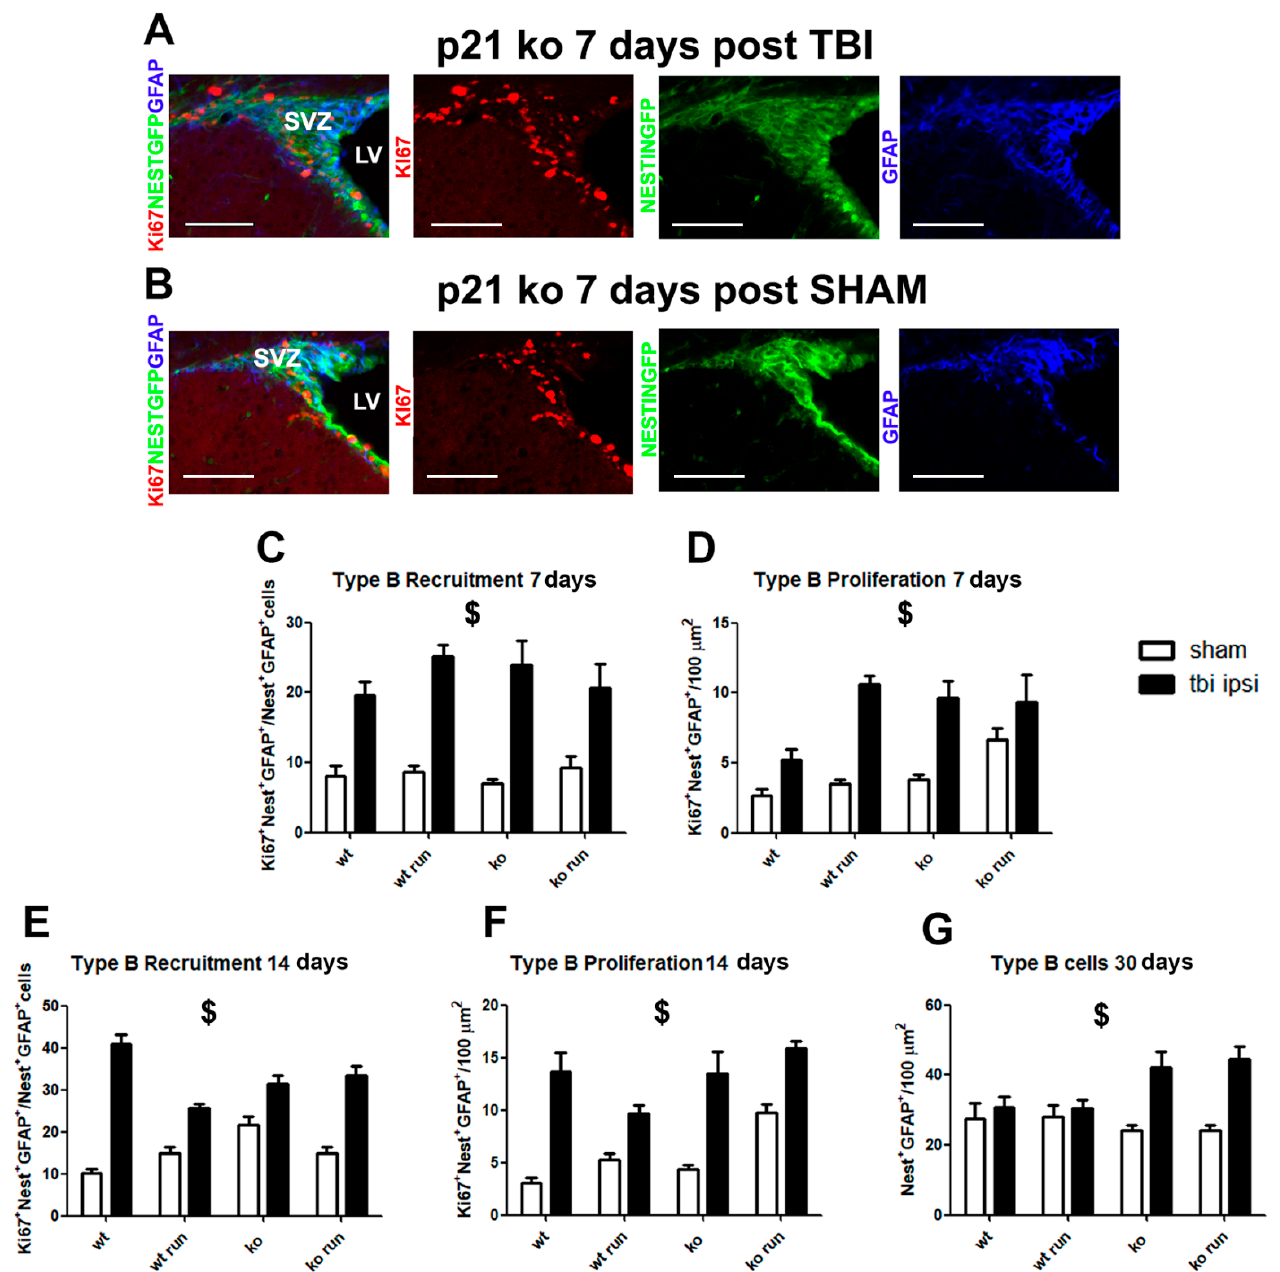
Figure 2. Modulation of type B cells after TBI. ( A , B ) Representative images in coronal sections of the neurogenic processes that occur in the ipsilateral SVZ of p21 ko mice 7 days after TBI (KO TBI, ( A )) and after SHAM (KO SHAM, ( B )). The images show an increment in the pool of proliferating type B cells (Ki67 + /GFAP + /NestinGFP + cells) in the KO TBI animals, with respect to the KO SHAM mice at 7 days after the surgery (N = 5 mice/group). ( C ) Graph shows the increase in type B recruitment at 7 days post TBI in the ipsilateral SVZ of the mice subjected to injury in comparison to their SHAM groups (ratio of Ki67 + NestinGFP + GFAP + cells/NestinGFP + GFAP + total cells, ipsilateral: lesion effect: F (1,60) = 91.45, p < 0.001). ( D ) Graph shows the enhancement of type B proliferation in the ipsi-lateral SVZ of TBI groups (Ki67 + NestinGFP + GFAP + cells, ipsilateral: lesion effect: F (1,60) = 45.8 p < 0.001). ( E ) Histograms illustrate the increase in type B recruitment in the ipsilateral SVZ in mice after 14 days from TBI (lesion effect: F (1,56) = 188, p < 0.001, $). ( F ) Graphs indicate an increase in type B proliferation in the ipsi-lateral SVZ of mice subjected to TBI 14 days after the trauma (lesion effect: F (1,56) = 85.9, p < 0.001). ( G ) After 30 days from TBI, we observed a significant increase in the type B cell population in the TBI mice with respect to their SHAM groups (NestinGFP + GFAP + cells, ipsilateral: lesion effect: F (1,44) = 21.76, p < 0.001, $). Statistical significance of main lesion effect between SHAM and TBI